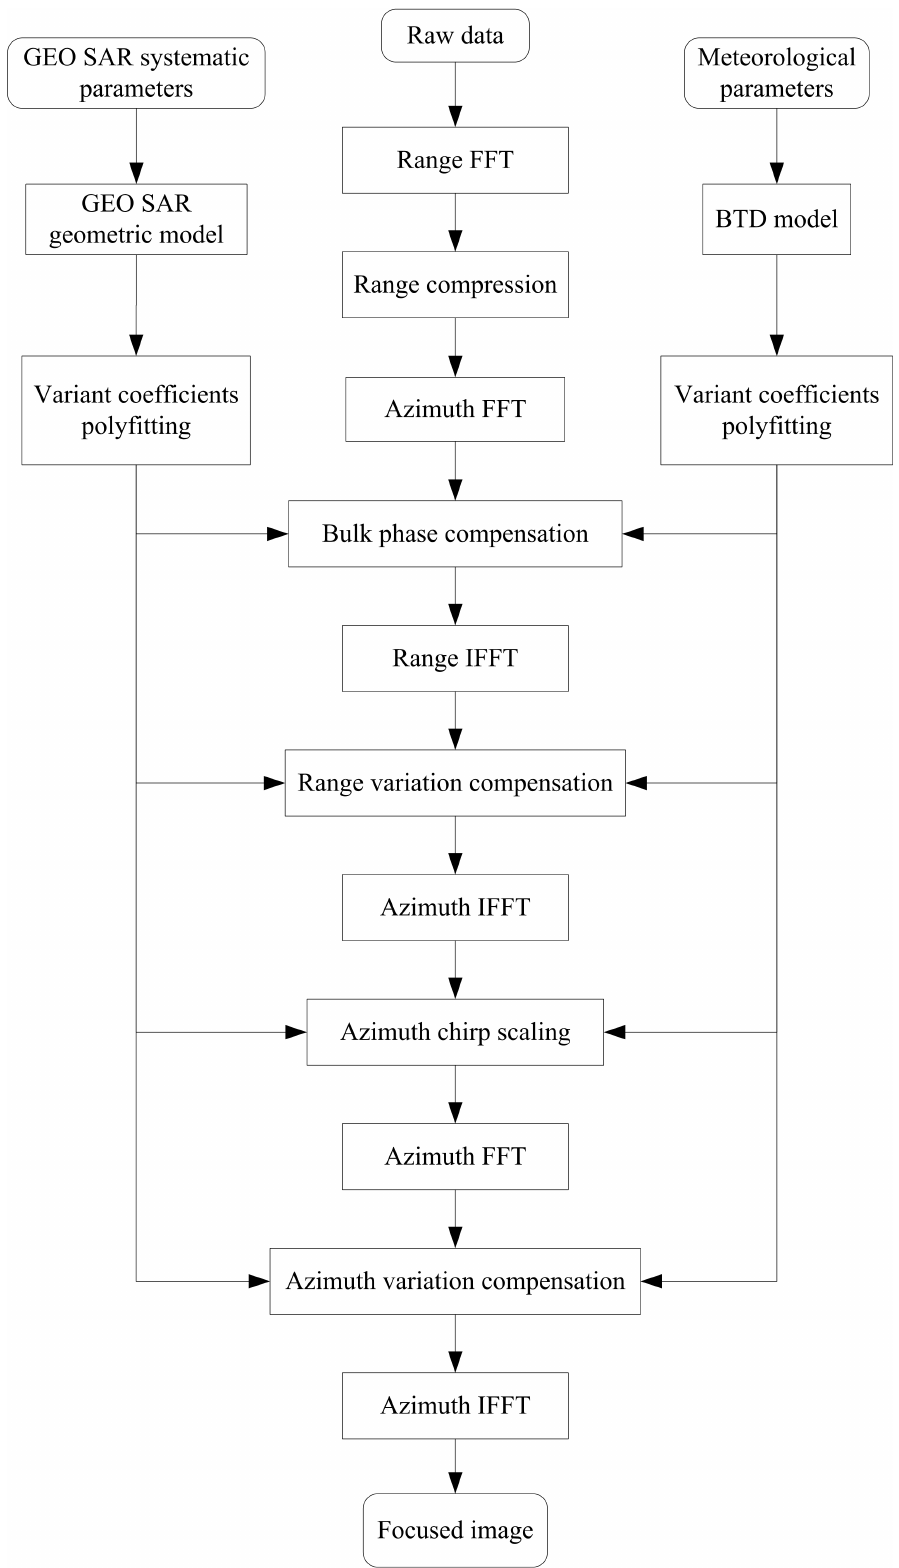
Figure 11. 2D spatially variant geometry model of GEO SAR